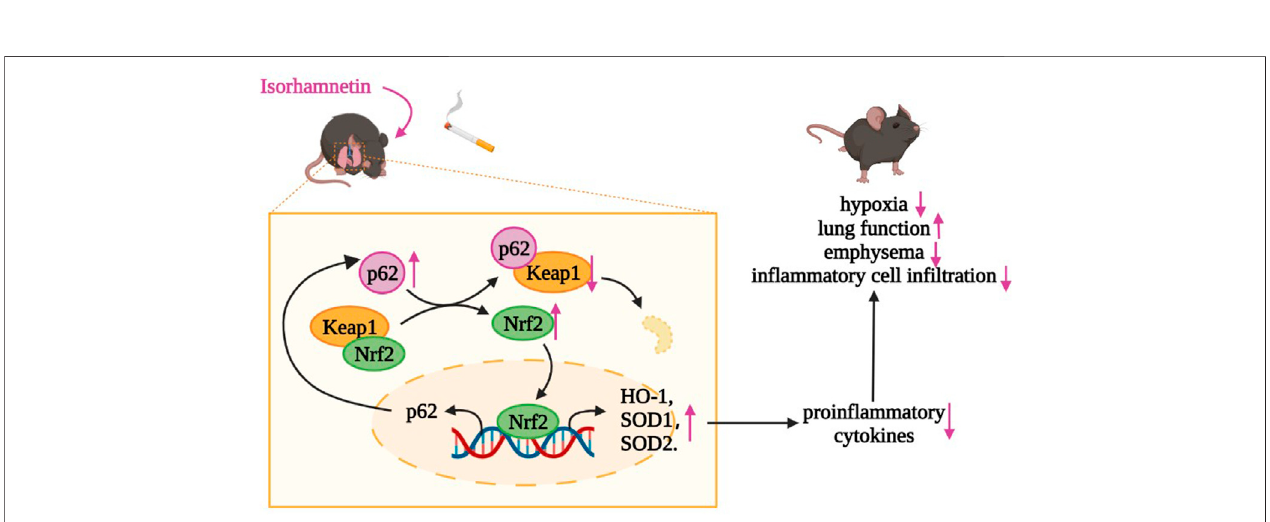
FIGURE 10 | Iso may degrade Keap1 through ubiquitination of p62, thereby activating the Nrf2 pathway to increase the expression of HO-1, SOD1, and SOD2 in lungs of CS-exposed mice, which plays an anti-in fl ammatory role in COPD.